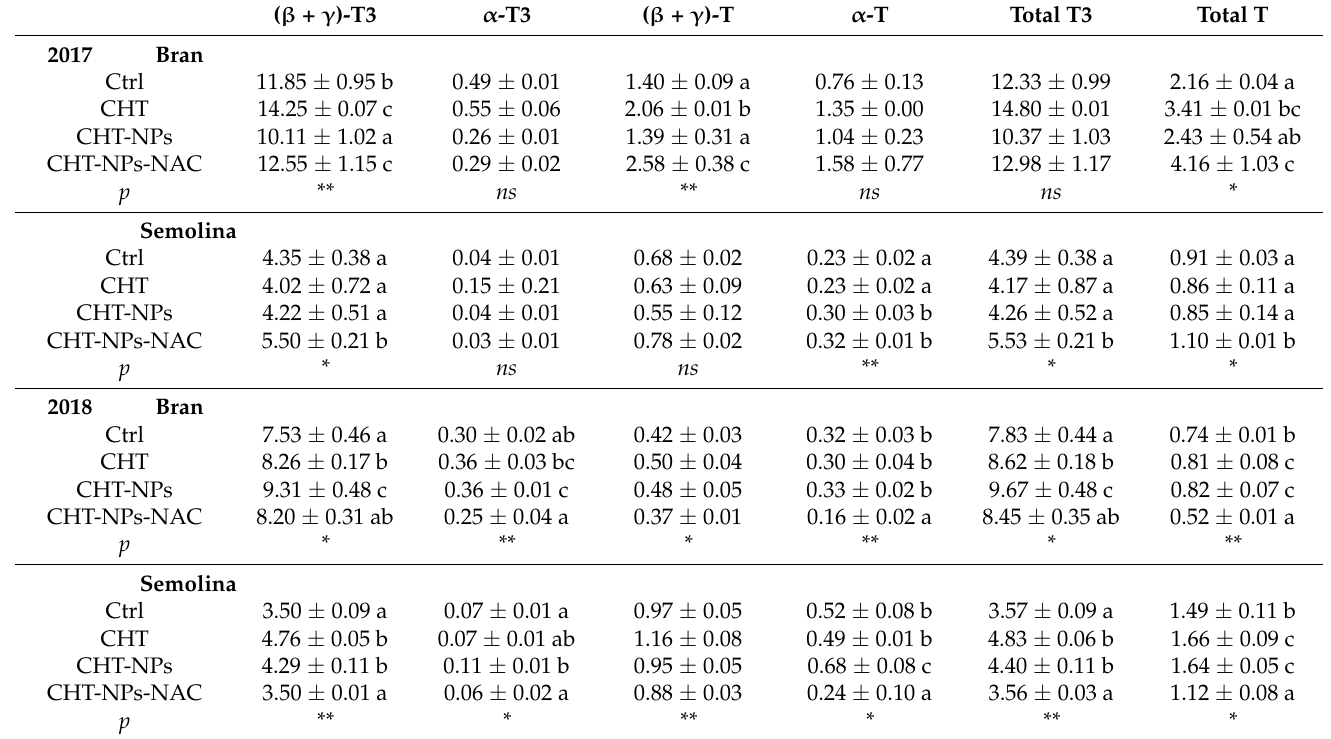
Table 2. Tocopherol and tocotrienol content (mg/100 g) in bran and semolina obtained from Triticum durum (cv. Fabulis) in 2017 and 2018, untreated (Ctrl) or treated with CHT, CHT-NPs, or CHT-NPs- NAC. All data are reported as mean ± standard deviation ( n = 3) a